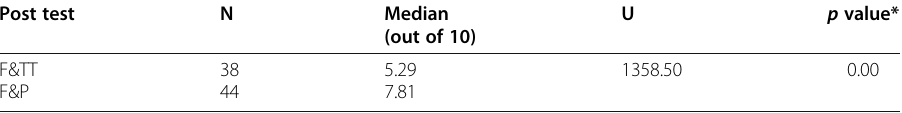
Table 4 Statistical difference analysis of the post-test after the F&TT and F&P implementation Post